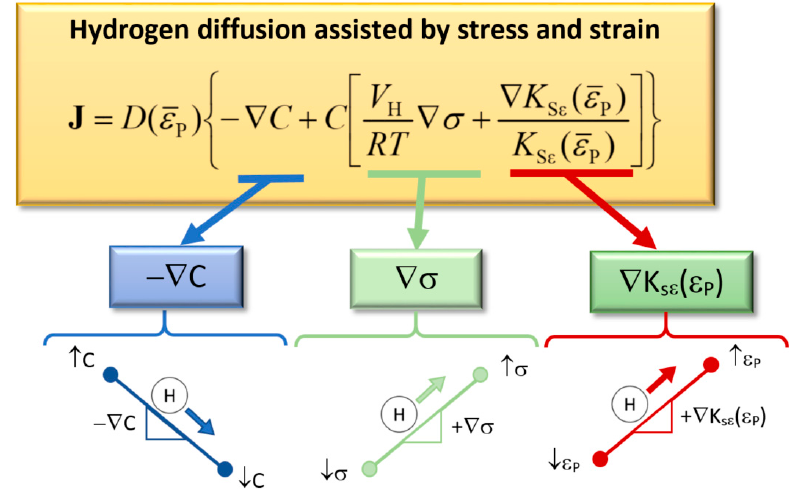
Figure 3. Scheme of the influence on hydrogen diffusion of the driven forces according to the model of diffusion assisted by stress and strain.